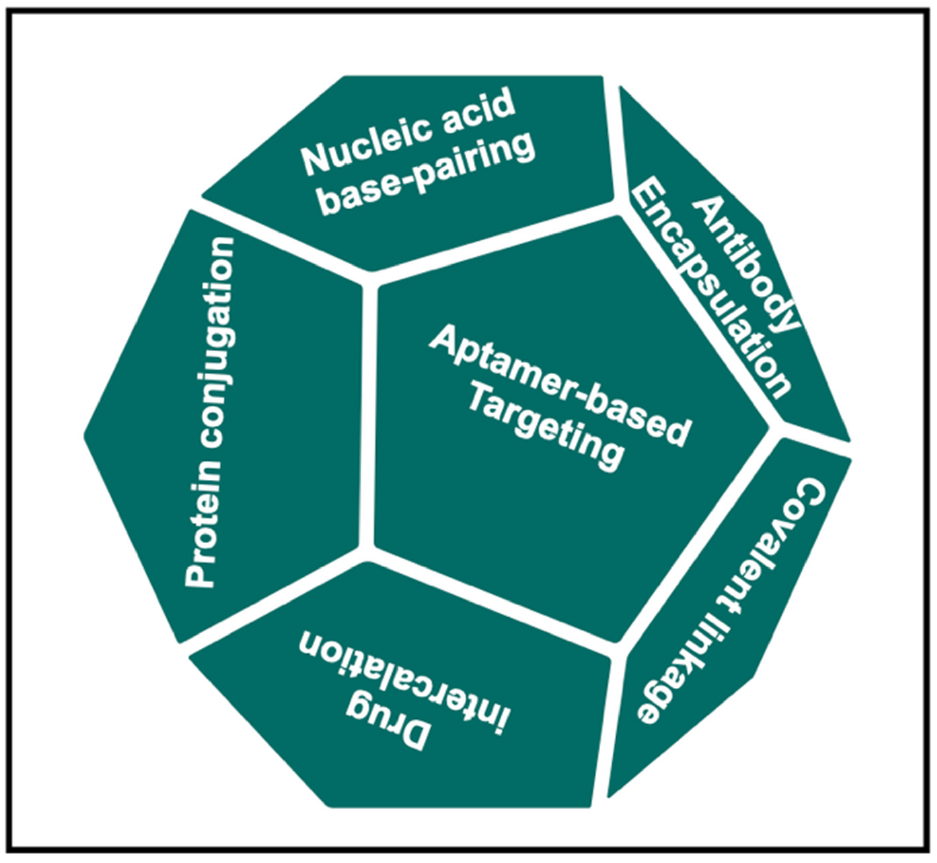
Figure 1. Scheme of self-assembled DNA nanocarriers for drug delivery using various cargo-loading strategies.